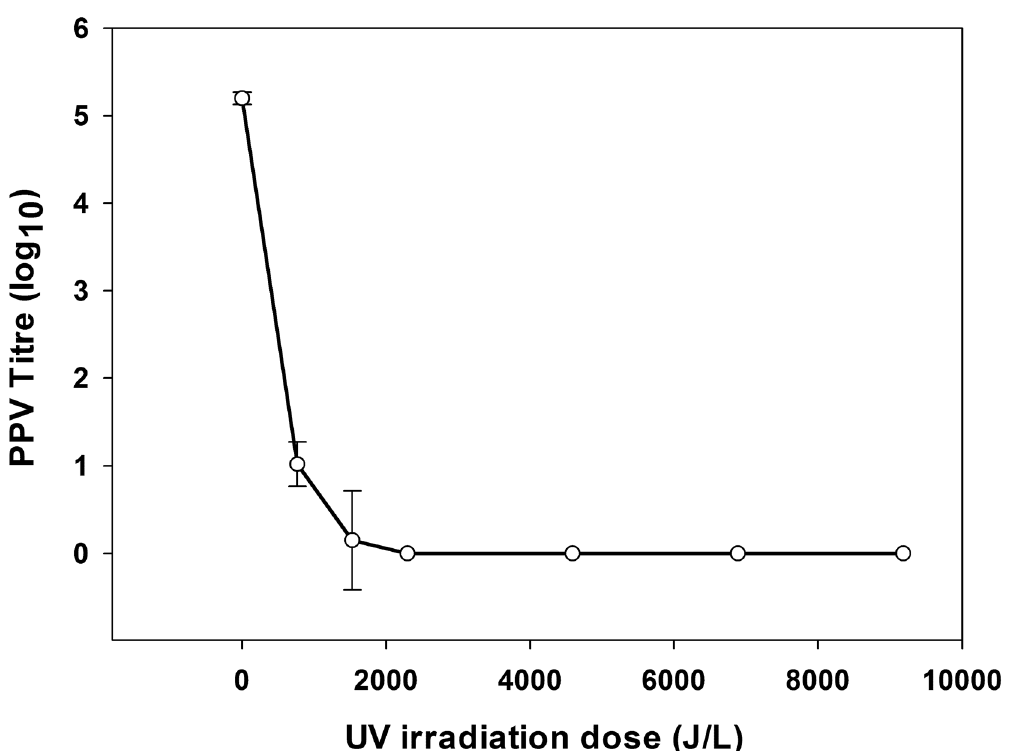
Fig 1. Porcine parvovirus virus inactivation in liquid bovine plasma after UV-C treatment. PPV titre expressed as log 10 ; mean and SE; n = 3.